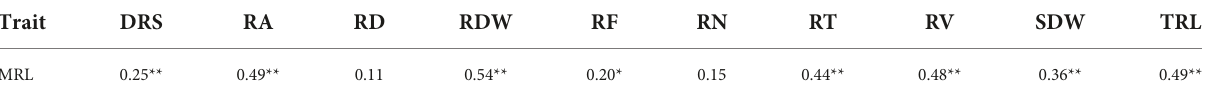
TABLE 2 Correlation coefficients between maximum root length (MRL) and root system architecture (RSA)-related traits in the 20828/SY95-71(2SY) population.